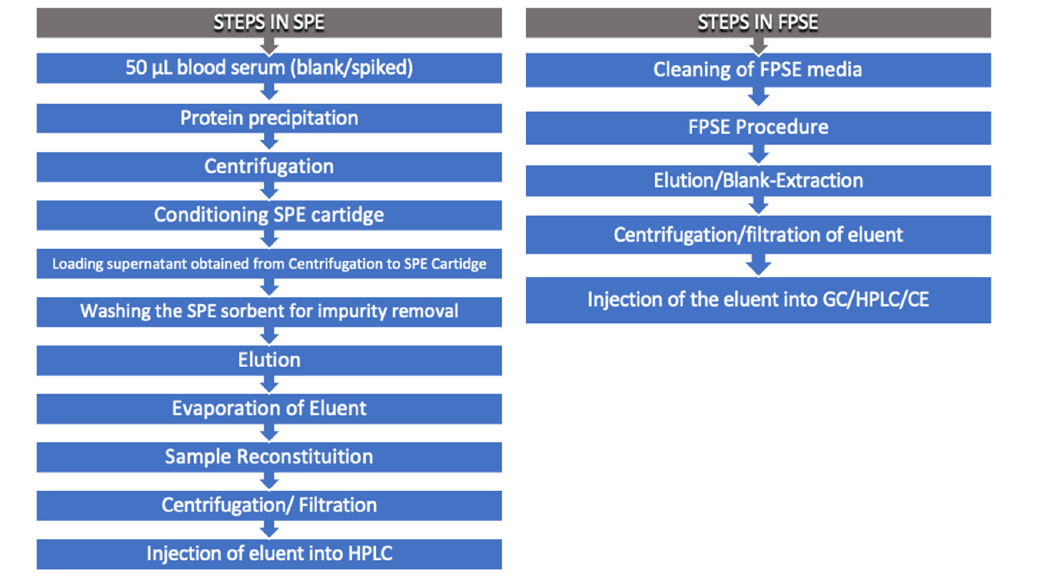
Figure 2. Comparison between solid-phase extraction (SPE) and fabric phase sorptive extraction